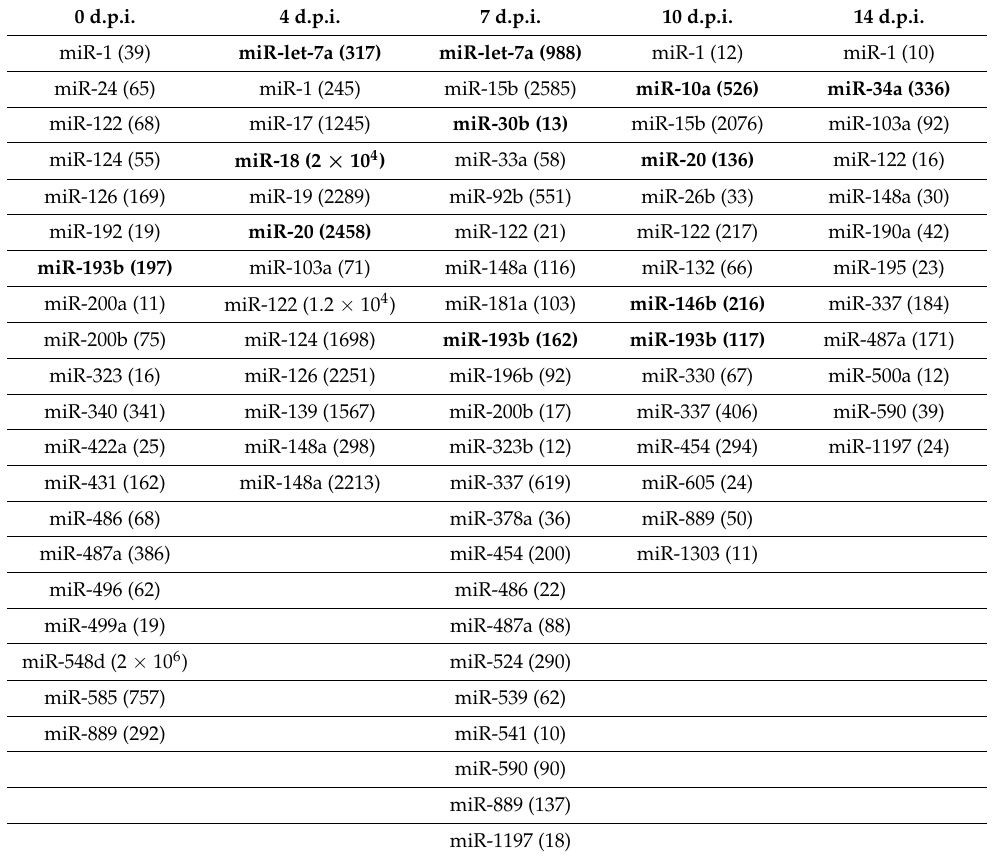
Table 5. Most down-regulated (> 10-fold) miRNAs in human herpesvirus 6A (HHV-6A) infected fibroblasts at 0, 4, 7, 10 and 14 days post-infection (d.p.i.) §¤. 0